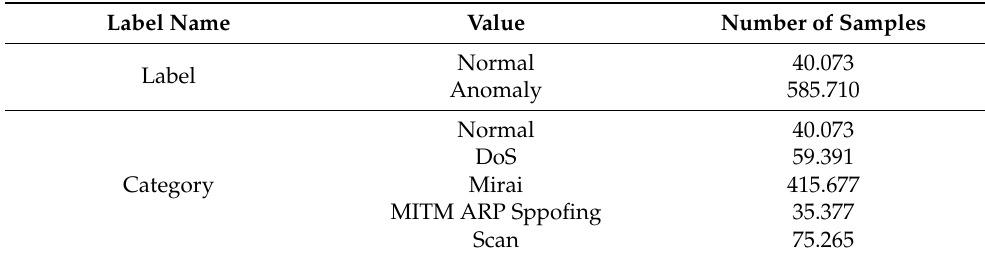
Table 1. IoTID20 dataset description.